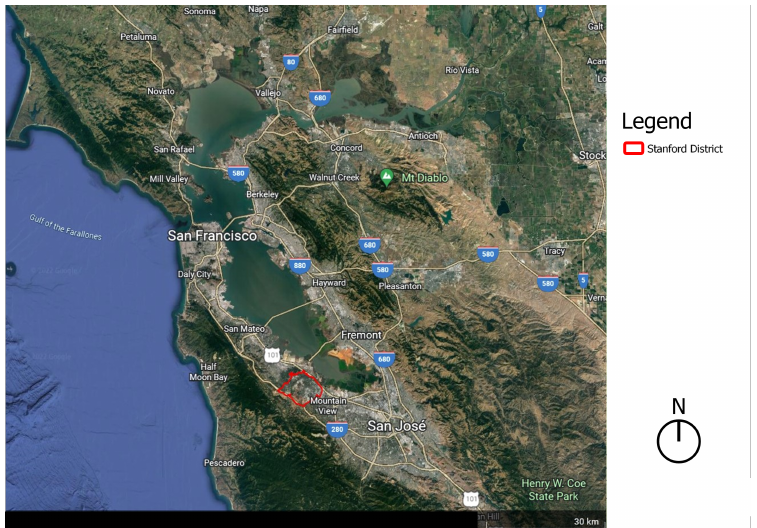
Figure 8. Stanford district within the San Francisco Bay